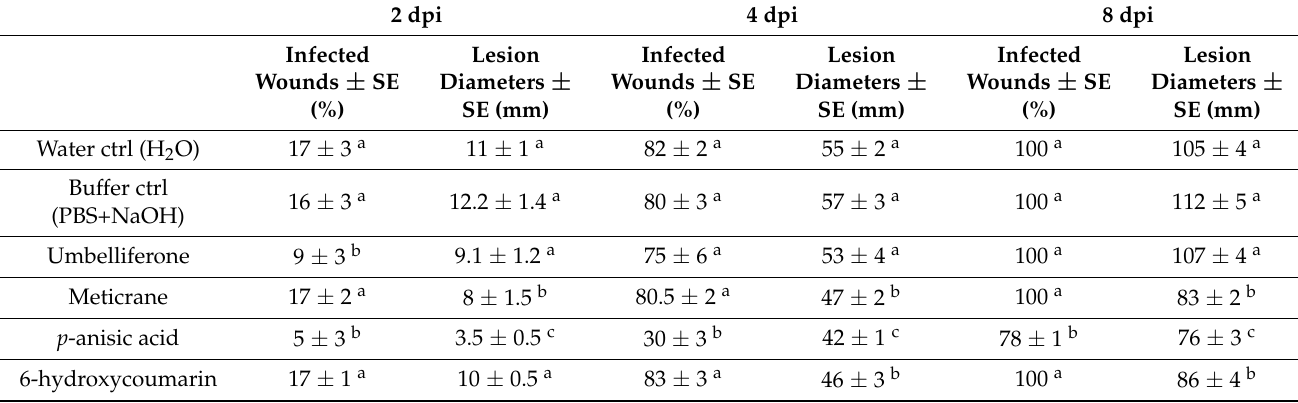
Table 3. Disease incidence (expressed as % of the infected wounds) and severity (expressed as lesion diameter, reported in mm) on Golden Delicious apples inoculated by P. expansum . Mean values and standard errors (SE) of at least three replicates are reported. Superscript letters (a–c) in each cell indicate whether the comparison (Duncan’s Multiple Range Test, DMRT test) between the corresponding pair of samples in a certain column returned a statistically significant difference ( p ≤ 0.05, different letters) or not (same